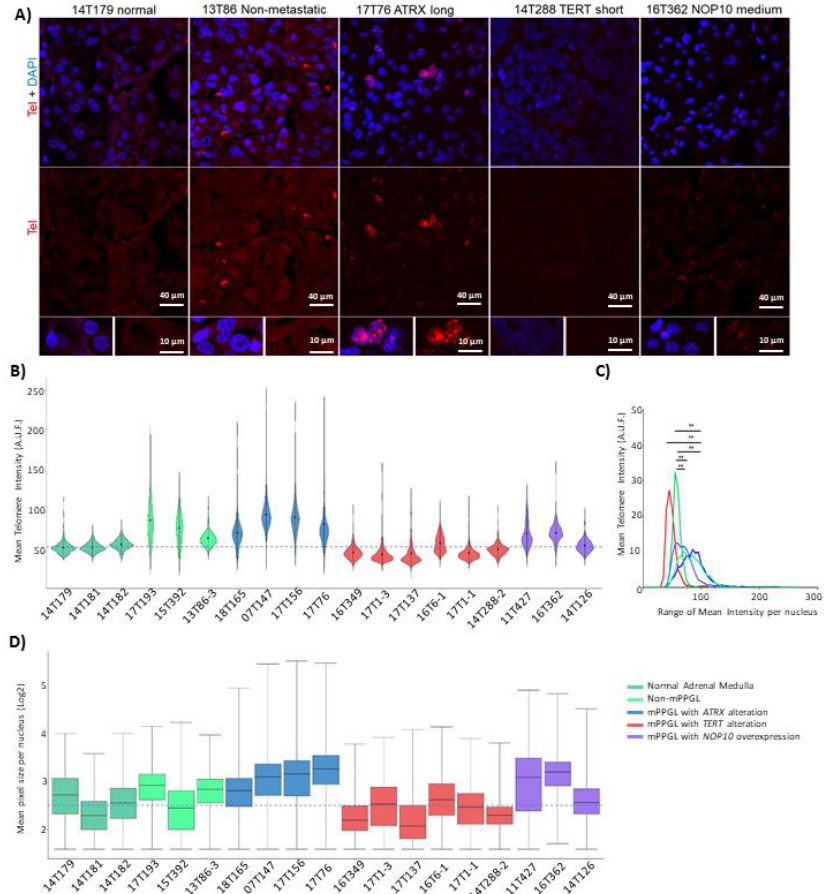
Figure 5. ( A ) Representative Q-FISH images from different tumors. 14T179: normal adrenal medulla with short telomeres. 13T86: non-metastatic PPGL with short telomeres. 17T76: mPPGL with ATRX mutation (c.3622dup, p.Ile1208AsnfsTer4) and long telomeres. 14T288: mPPGL with extremely short telomeres, this patient has TERT overexpression, promoter hypermethylation and 5p amplification. 16T362: mPPGL with medium-long telomeres and NOP10 overexpression. ( B ) Violin plot of telomere mean intensity per nucleus. Highest values (upper end) represent long telomeric regions. Black dots inside each violin box represent median intensity value. Dashed line represents the median value of normal samples intensity (normal adrenal medulla, n = 3). Non-mPPGL: 17T193 ( FGFR1 -mutated); 15T392 (WT); 13T86-3 ( SDHB -mutated). ( C ) Mean telomere intensity distribution for each group of samples (Wilcoxon matched-pairs signed rank test, Gaussian Approximation). ( D ) Box plot representing the mean telomere size (mean pixel size per nucleus) for each tumor: ATRX mutants have extremely long telomeres, NOP10 -altered samples show intermediate-long telomeres, TERT -altered present extremely short telomeres. Normal and non-metastatic samples have medium-short telomeres. Dashed line represents the median value of normal samples’ telomere size. The color code chart applies to panels B , C and D (one-way ANOVA Tukey’s multiple comparison test: **: p -value <